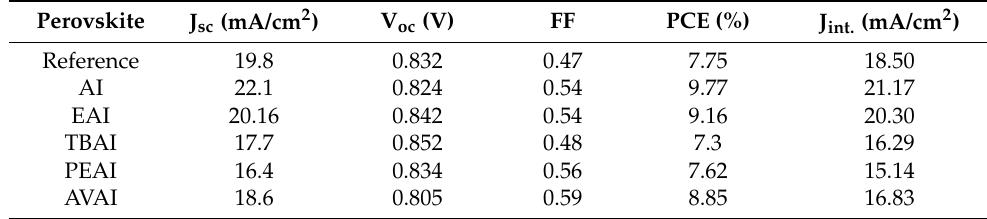
Table 5. Electrical parameters derived from the J-V curves of the champion C-PSCs under